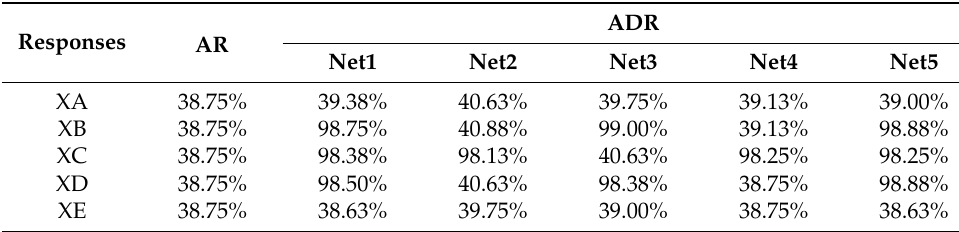
Table 2. Anomaly detection results of test sets.